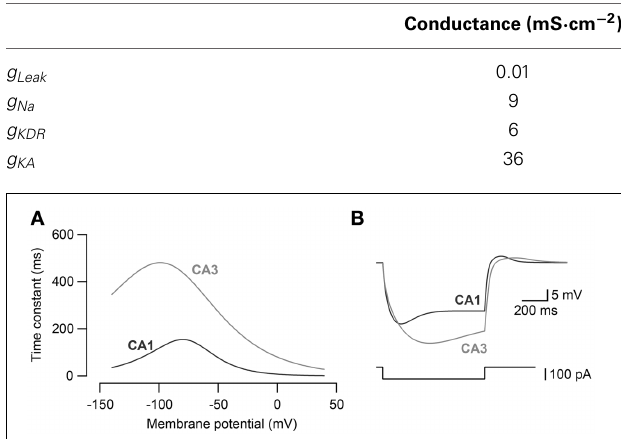
Table 2 | Maximal conductance of voltage-gated conductance in CA1 and CA3 pyramidal neuron model.